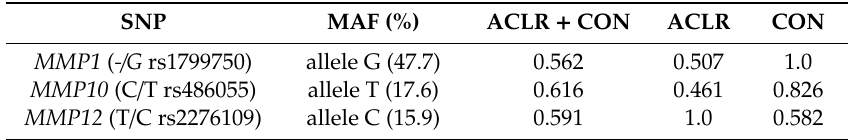
Table 1. Minor allele frequencies (MAF) and Hardy-Weinberg equilibrium probabilities for the investigated variants (state variants) in the control and anterior cruciate ligament rupture groups investigated in the recruited Polish